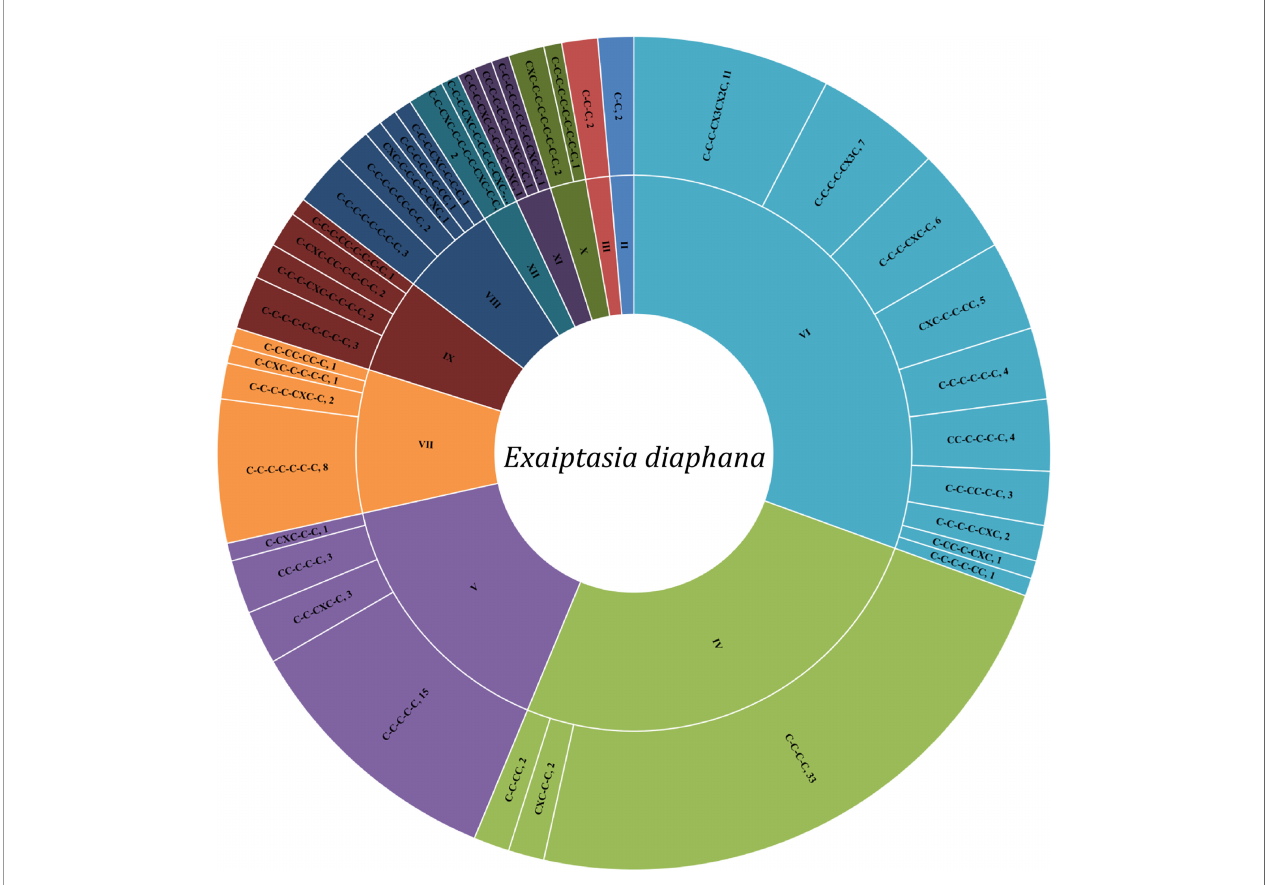
FIGURE 3 | Classi fi cation of cysteine patterns of peptide neurotoxins from Exaiptasia diaphana